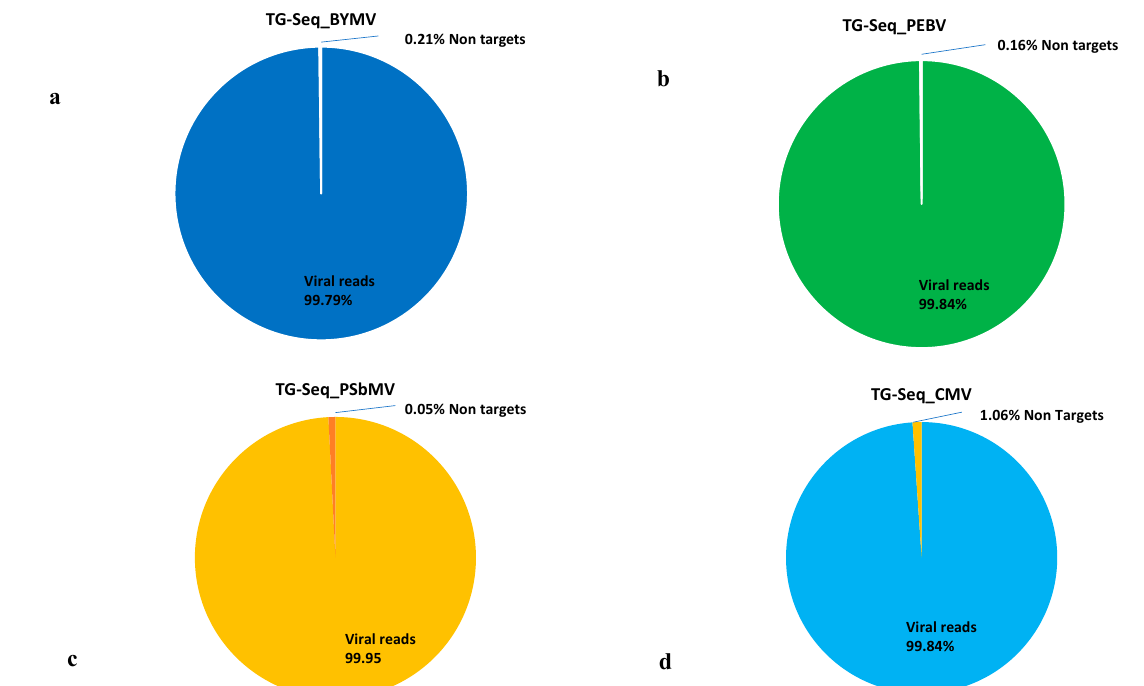
Figure 3. The proportion of number of reads generated through singleplex TG-Seq after mapping back to the region of interest. ( a ) BYMV-TG-Seq library, ( b ) PEBV-TG-Seq library, ( c ) PSbMV- TG-Seq library, ( d ) CMV-TG-Seq library.